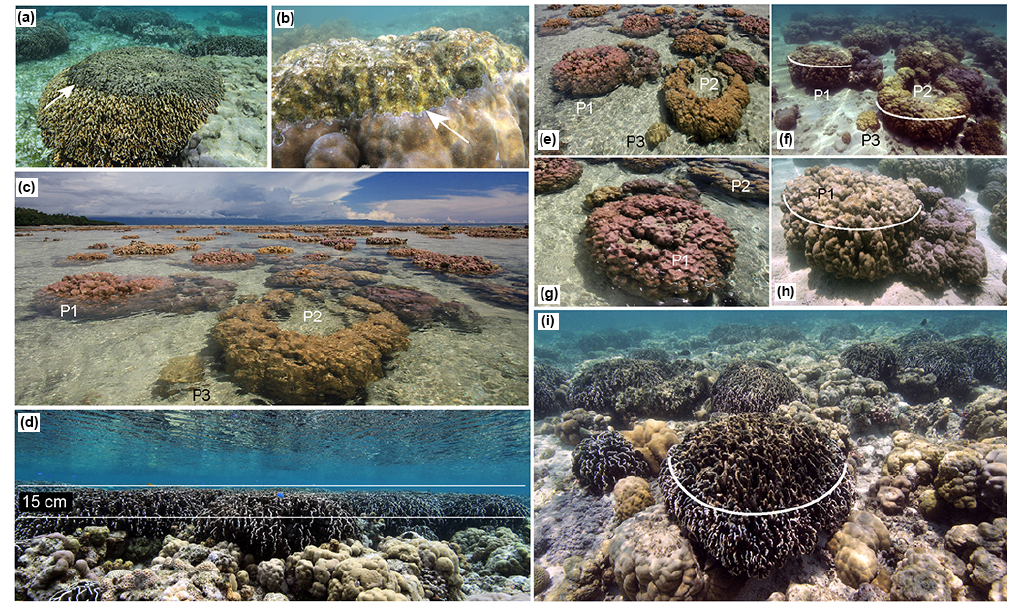
Figure 1. Bunaken reef flats. (a) Close-up of one Heliopora coerula colony with clear tissue mortality on the upper part of the colonies; (b) same for a Porites lutea colony; (c) reef flat Porites colonies observed at low spring tide in May 2014. Even partially above water a few hours per month in similar conditions, the entire colonies were alive. (d) A living Heliopora coerula (blue coral) community in 2015 in a keep-up position relative to mean low sea level, with almost all the space occupied by corals. In that case, a 15cm sea level fall will impact most of the reef flat. (e–h) Before–after comparison of coral status for colonies visible in (c) . In (e) , healthy Porites lutea (yellow and pink massive corals) reef flat colonies in May 2014, observed at low spring tide. The upper part of colonies is above water, yet healthy; (f) same colonies in February 2016. The white lines visualize tissue mortality limit. Large Porites colonies (P1, P2) at low tide levels in 2014 are affected, while lower colonies (P3) are not. (g) P1 colony in 2014. (h) Viewed from another angle, the P1 colony in February 2016. (i) Reef flat community with scattered Heliopora colonies in February 2016, with tissue mortality and algal turf